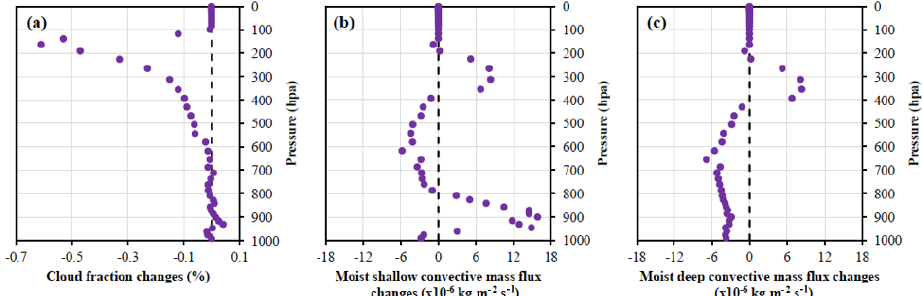
Figure 8. Changes in vertical cloud fractions (a) , shallow convective mass flux (b) and deep convective mass flux (c) within the India and Indian Ocean domain from global solid fuel cookstove emissions.